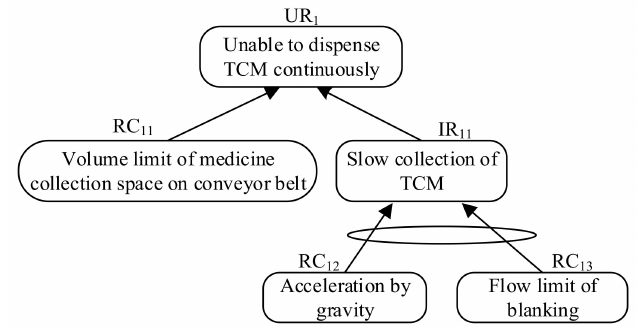
Figure 16. CRT model of “Unable to dispense TCM continuously”.